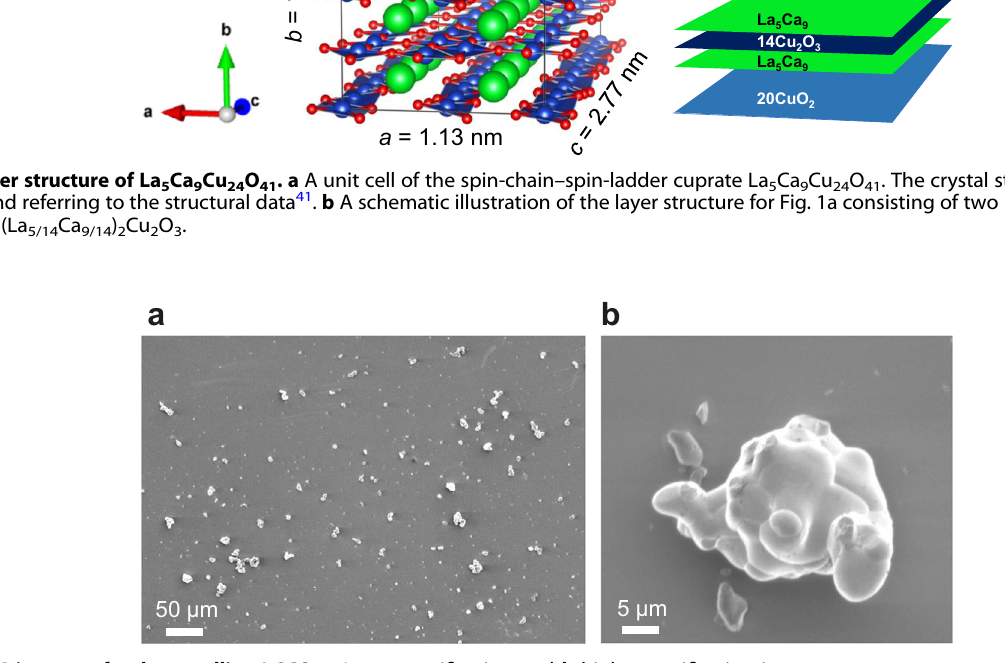
Fig. 2 SEM images of polycrystalline LCCO. a Low-magni fi cation and b high-magni fi cation